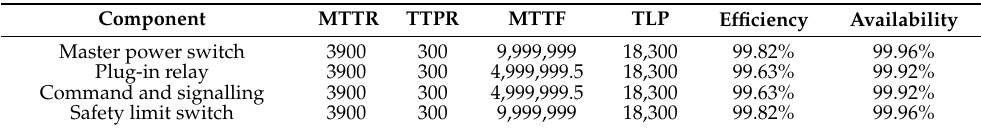
Table 10. Electrical component times in seconds. Efficiency and availability calculated in % with the IPPM strategy.